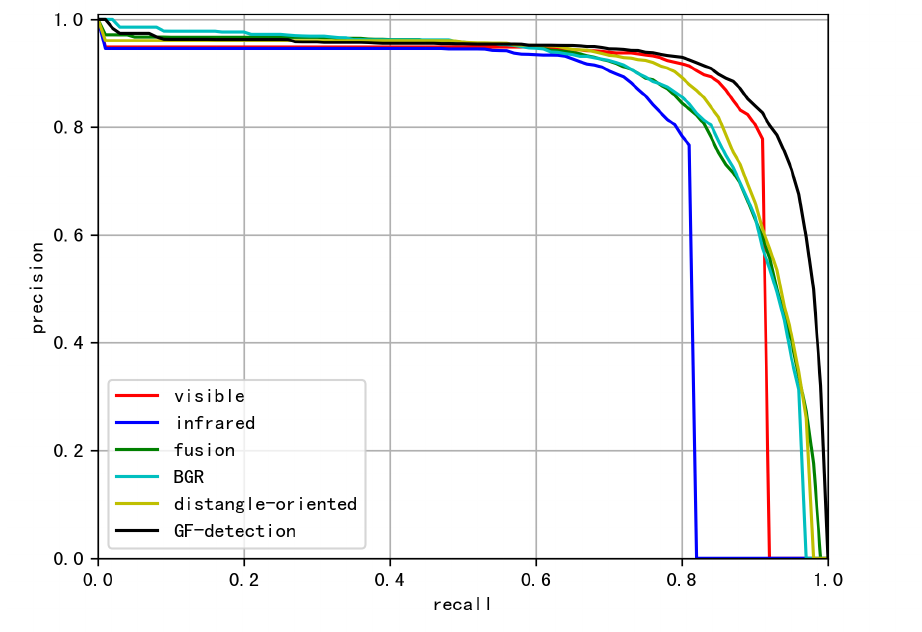
Figure 5. PR-Curve of six fusion